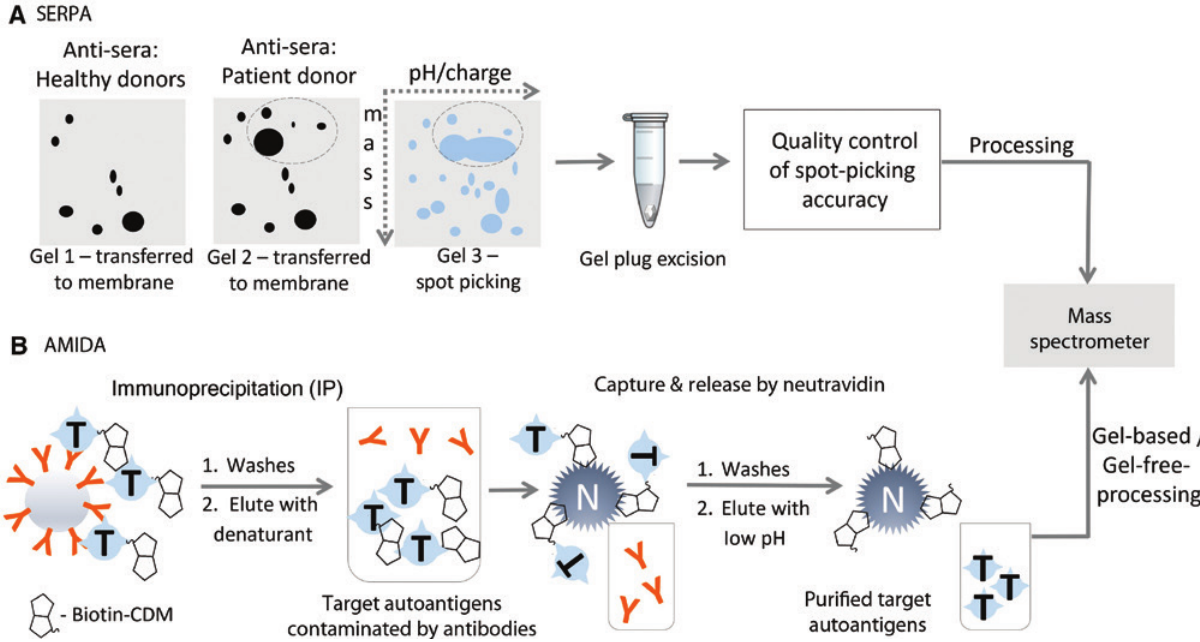
Figure 1: Mass spectrometry based immunoproteomics